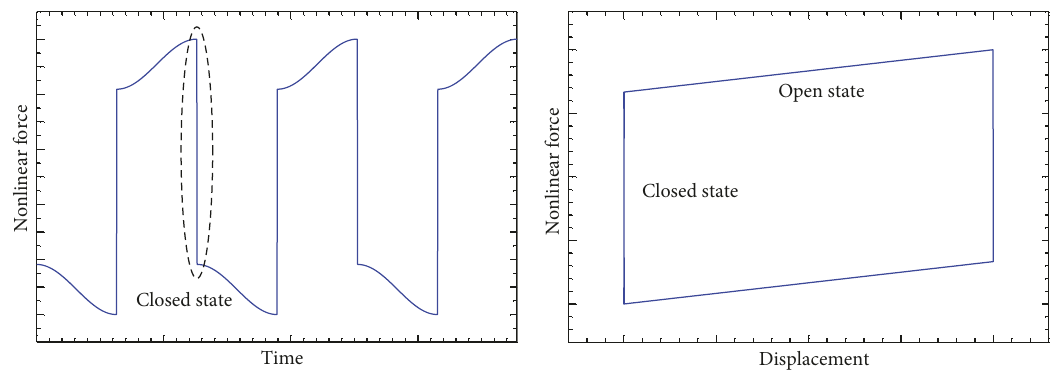
Figure 3: Nonlinear force in the time domain.